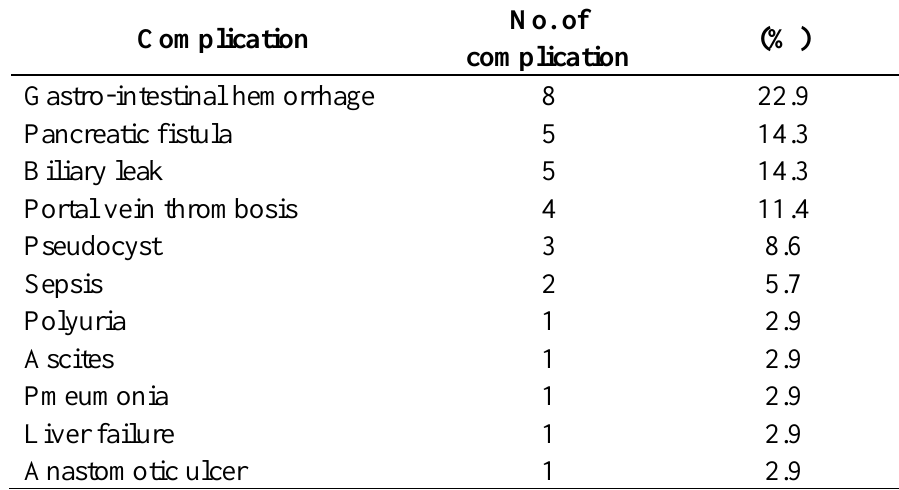
Table 4. Type and frequency of postoperative complications in 30 patients who received radiofrequency ablation for pancreatic adenocarcinoma. One or more complication may be present in the same